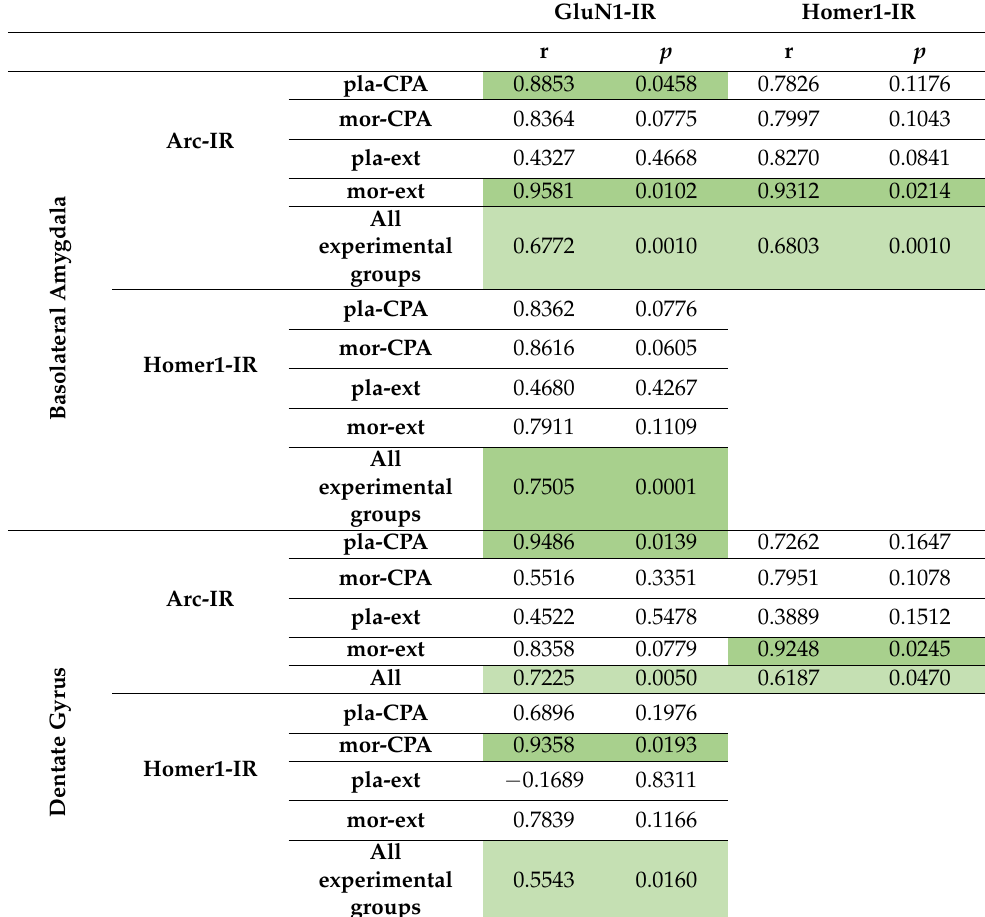
Table 3. Correlations between Arc-, GluN1-, and Homer1-IR in the BLA and DG.